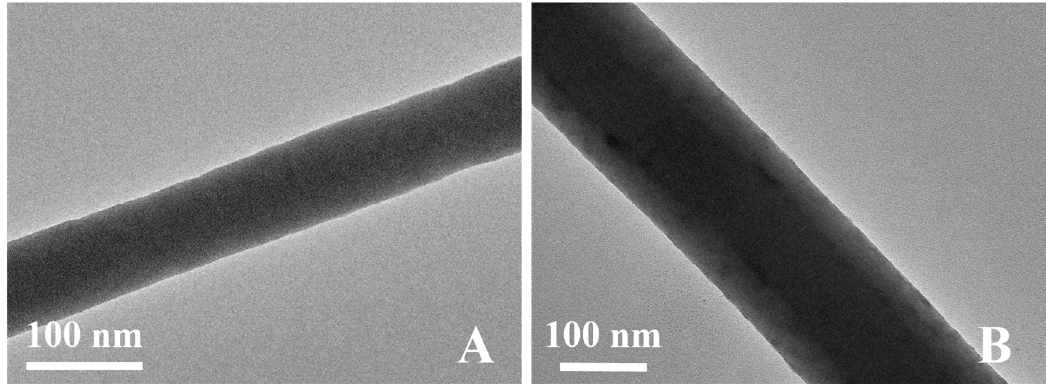
Figure 2. Transmission electron microscopy (TEM) images of: ( A ) electrospun PAN nanofibers; and ( B ) PAN@TiO 2 nanofibers.